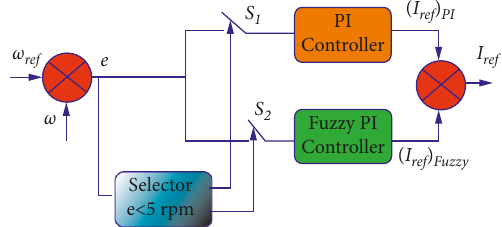
Figure 21: PI-based fuzzy controller